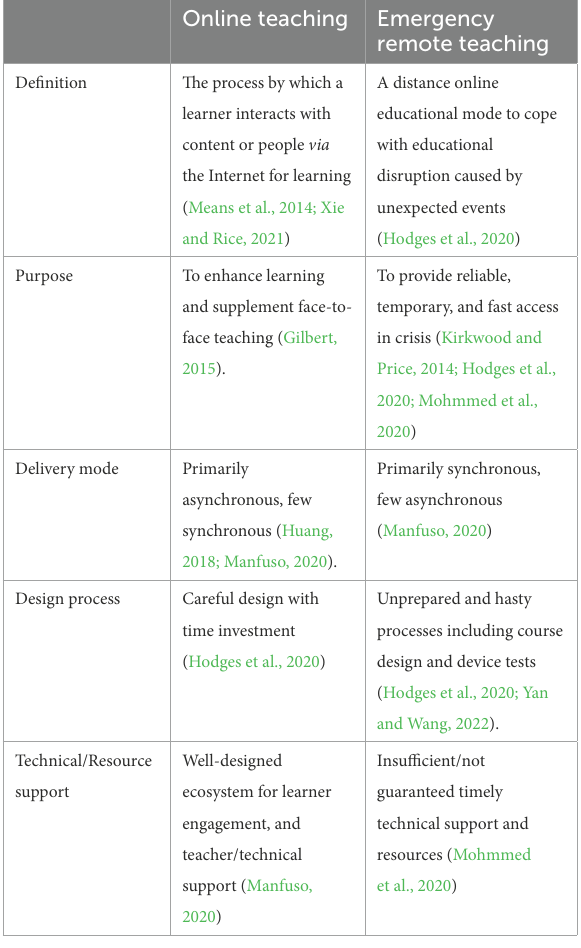
TABLE 1 Features of online teaching and emergency remote